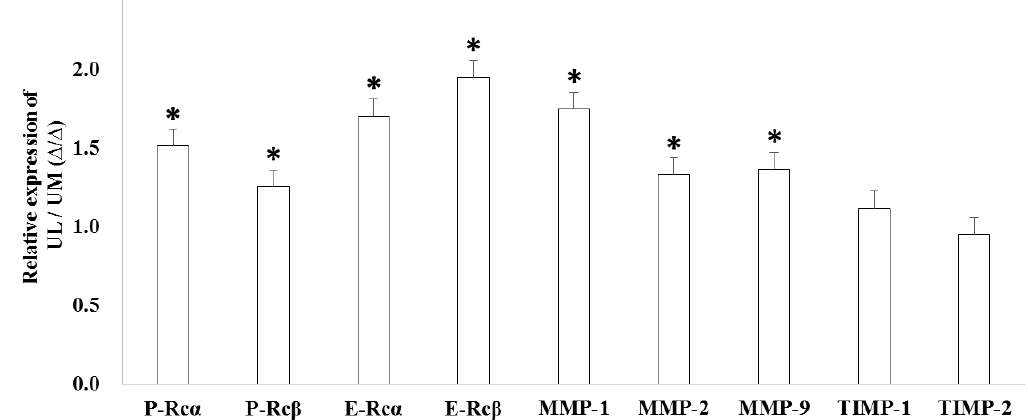
Figure 3. The relative candidate target gene expression in uterine leiomyoma cells compared to uterine myometrial cells (* p < 0.05).